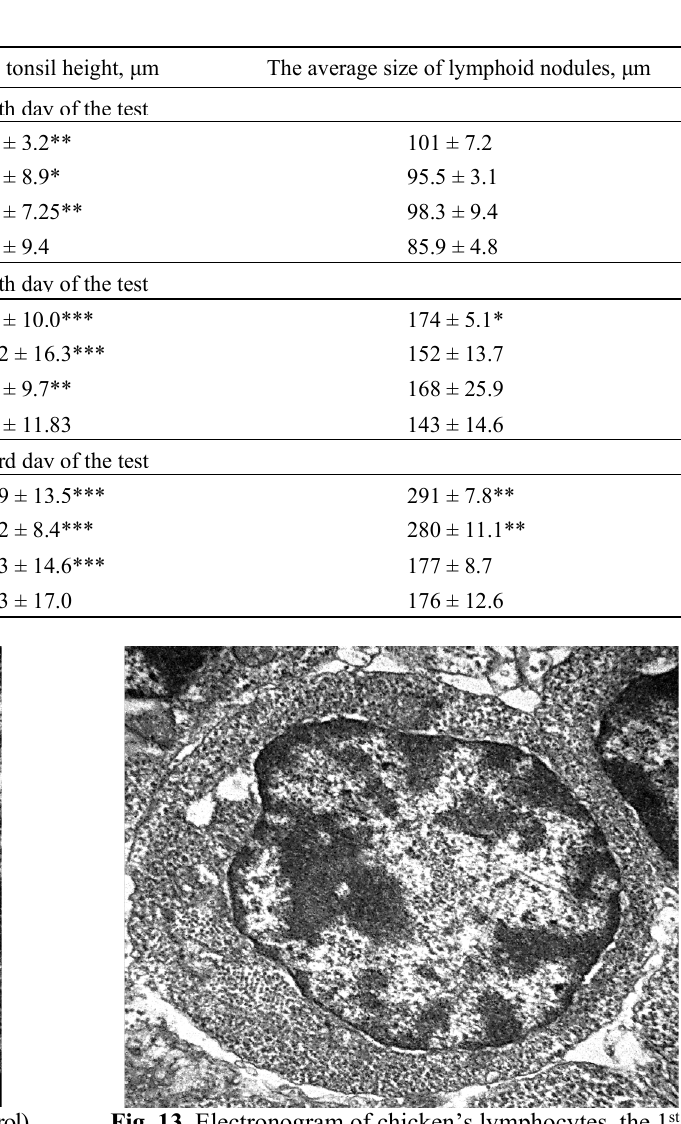
Dynamics of morphometric parameters of broiler chicken’s caecal tonsils at the application of probiotic feed additives (M ± m,